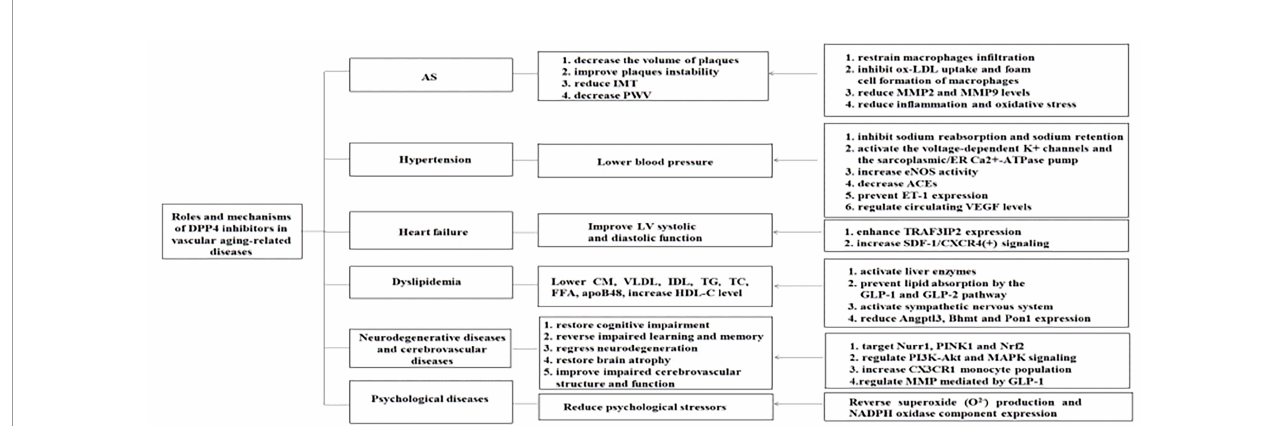
FIGURE 1 | Roles and mechanisms of DPP4 inhibitors in vascular aging -related diseases. DPP4 inhibitors play an effective effect against vascular aging-related diseases through multiple mechanisms. AS, atherosclerosis; JMT, intima-media thickness; PWV, pulse wave velocity; LV, left ventricular; CM, chylomicrons; VLDL, very low density lipoprotein; IDL, intermediate density lipoprotein; TG, triglyceride; TC, total cholesterol; FFA, free fatty acid; apoB48, apolipoprotein B-48; HDL-C, high-density lipoprotein cholesterol; MMP2, macrophage matrix metalloprotcinase-2; MMP9, macrophage matrix metalloproteinasc-9; ER, endoplasmic reticulum; eNOS, endothelial nitric oxide synthase; ACEs, angiotensin-converting enzymes; ET-1, endothelin-1 ; VEGF, vascular endothelial growth factor; TRAF3IP2,TRAF3, Interacting Protein 2; SDF-1, stromal cell-derived factor-I a ; CXCR4, C-X-C chemokine receptor type-4; GLP-1 , glucagon-like peptide-1; GLP-2, glucagon-like peptide-2; Angptl3, angiopoietin-like 3; Bhmt, betaine-homocysteine S-mcthyltransferasc; Pon1, paraoxonasc-1; Nurrl, nuclear receptor related I ; PINK1, PTEN-i nduced putative kinase 1; Nrf2, nuclear factor erythroid 2-related factor 2; PI3K, phosphoinositide-3-kinase; Akt, v-akt murine thymoma viral oncogene homologue; MAPK, mitogen-activated protein kinase; NADPH, nicotinamide adenine dinucleotide